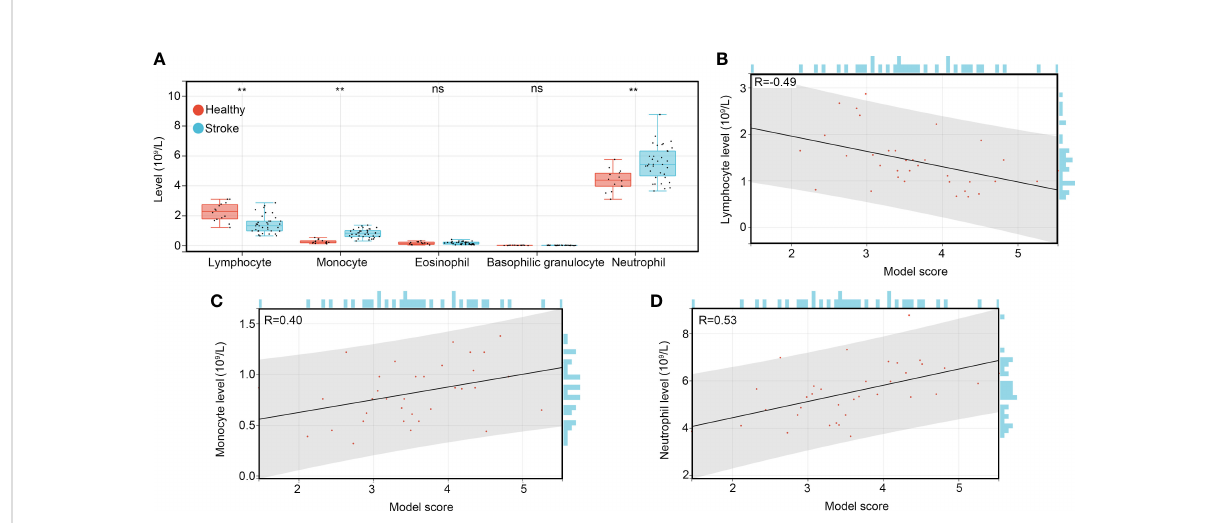
FIGURE 7 The diagnostic model can re fl ect the condition of immune-related cells in patients with IS. (A) The levels of immune-related cells such as lymphocytes, monocytes, eosinophils, basophilic granulocytes and neutrophils in the whole blood of healthy controls, patients with IS, and patients with CH. (B) The co-expression relationship between the diagnostic model score and levels of lymphocytes. (C) The co-expression relationship between the diagnostic model score and levels of monocytes. (D) The co-expression relationship between the diagnostic model score and levels of neutrophils. **P<0.01; ns, no signi fi cance,